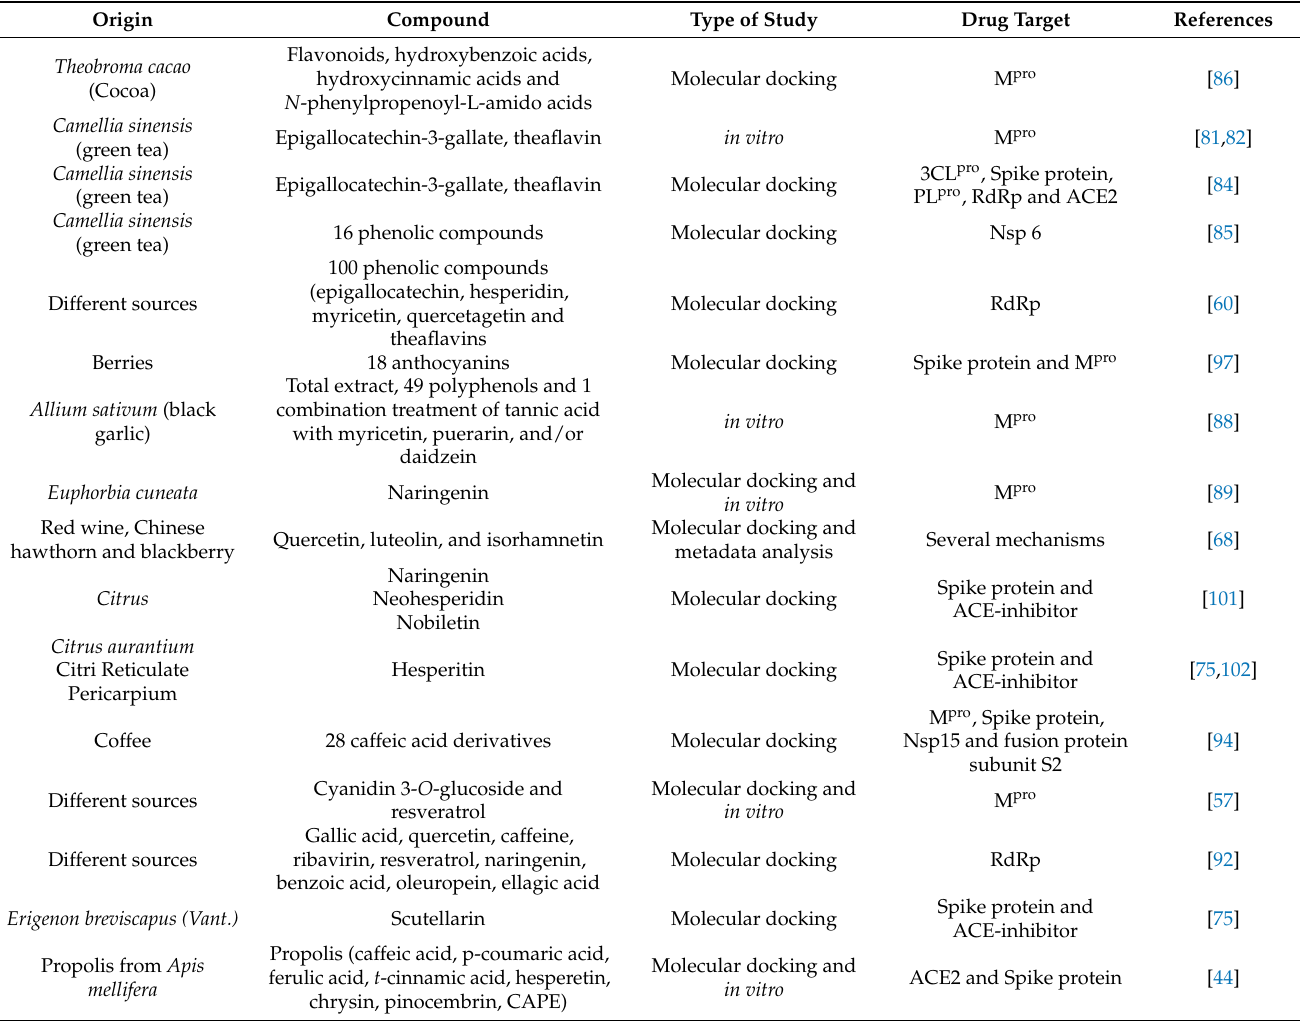
Table 2. Examples of the use of rich-phenolic foods and dietary supplements in SARS-CoV-2 inhibition.